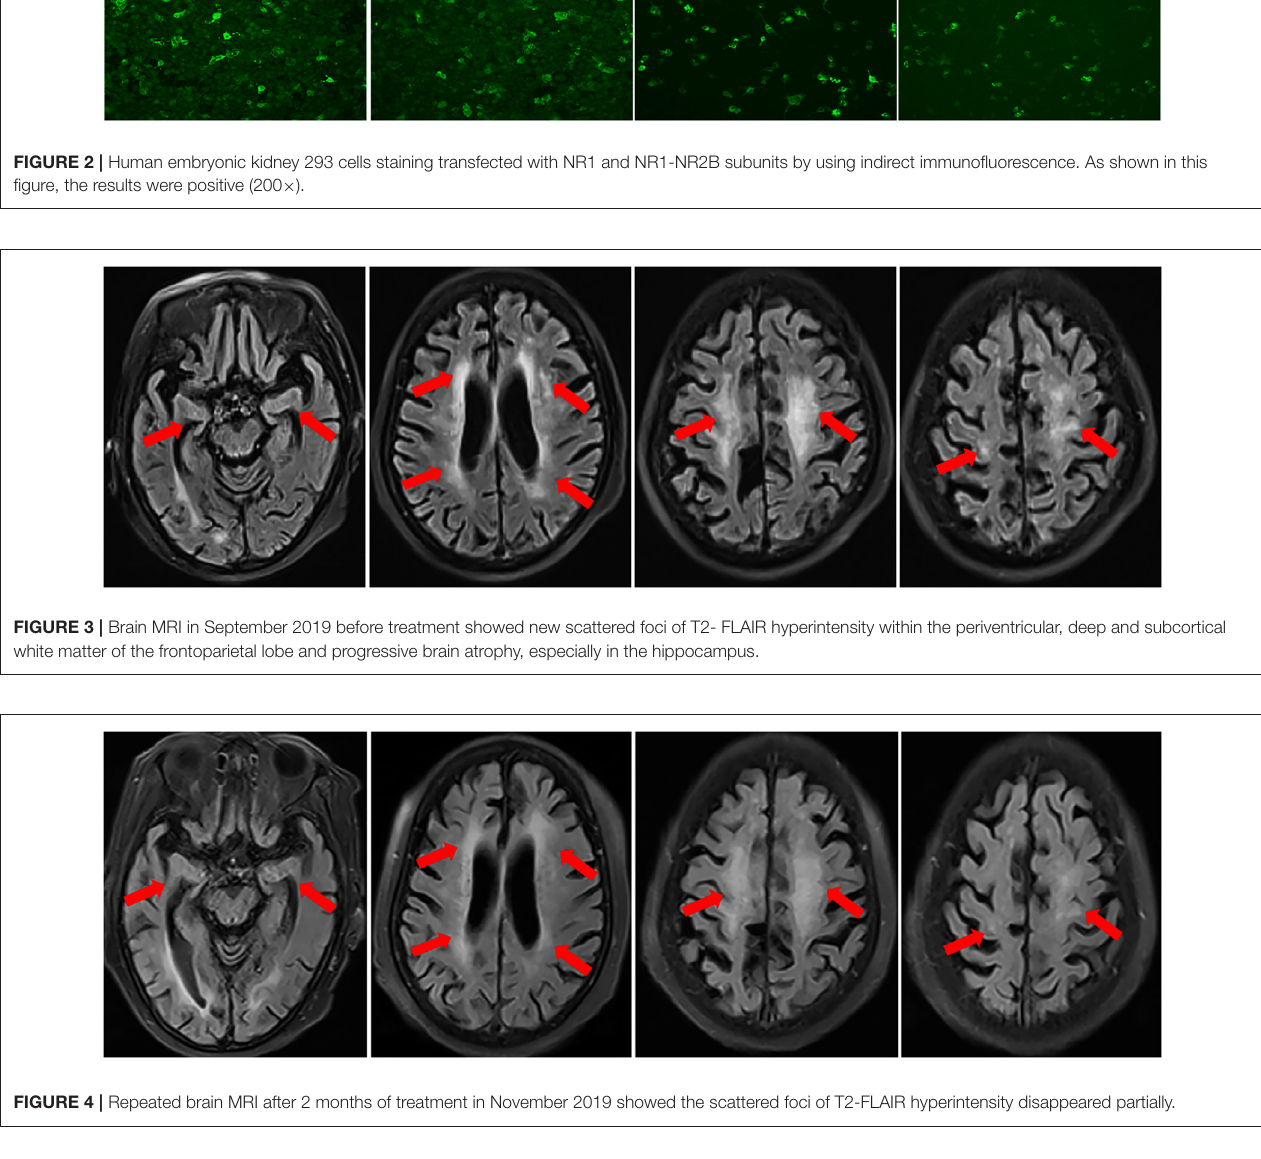
related to the antibodies against NR1 subunit of